Question: Reading the figure, is the described quantity rising or falling?
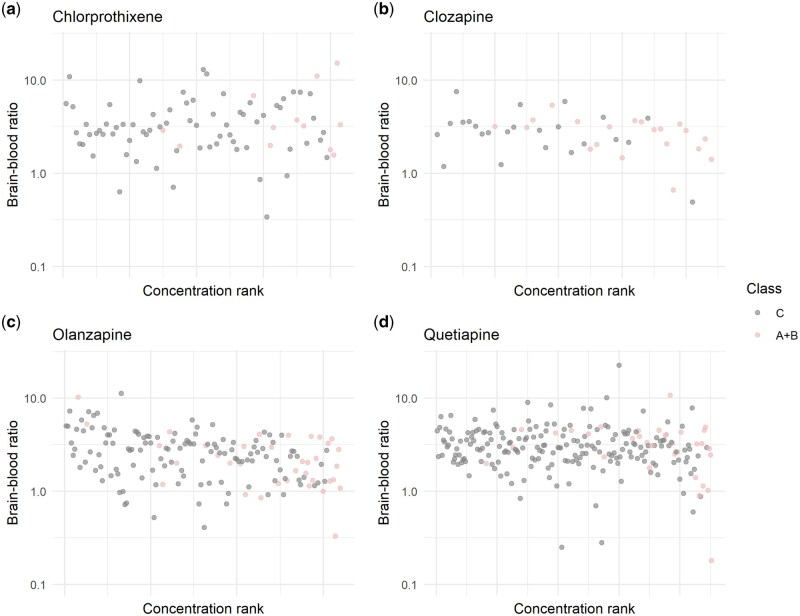
Answer: increasing